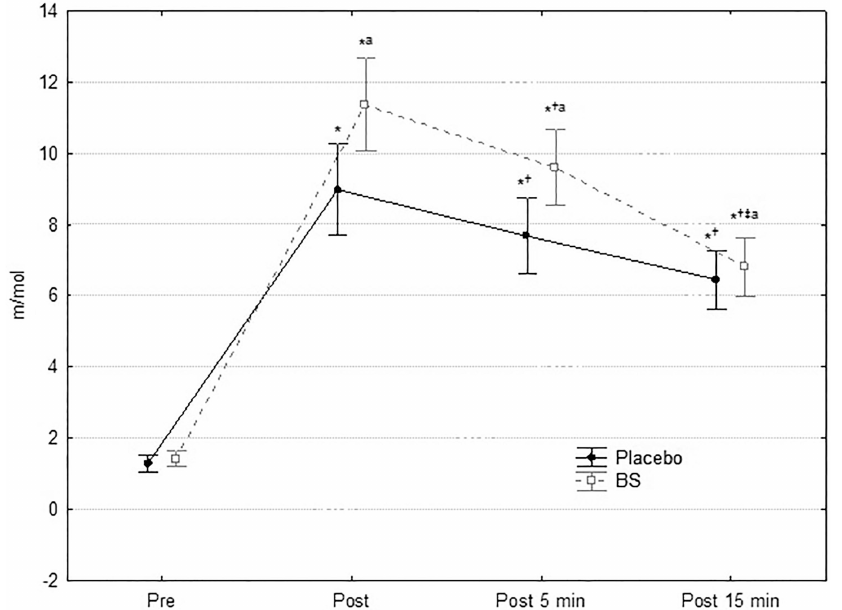
Figure 3 - Lactate concentrations at pre-exercise (Pre), and immediately (Post), 5 minutes (Post 5 min), and 15 minutes (Post 15 min) after completing three upper body exercises in different supplementation condition (Data are mean ± SD). * Significant difference to the Pre (p ≤ 0.05).; † Significant dif- ference to the Post (p ≤ 0.05).; ‡ Significant difference to the Post 5 min (p ≤ 0.05).; a Significant difference to BS condition (p ≤